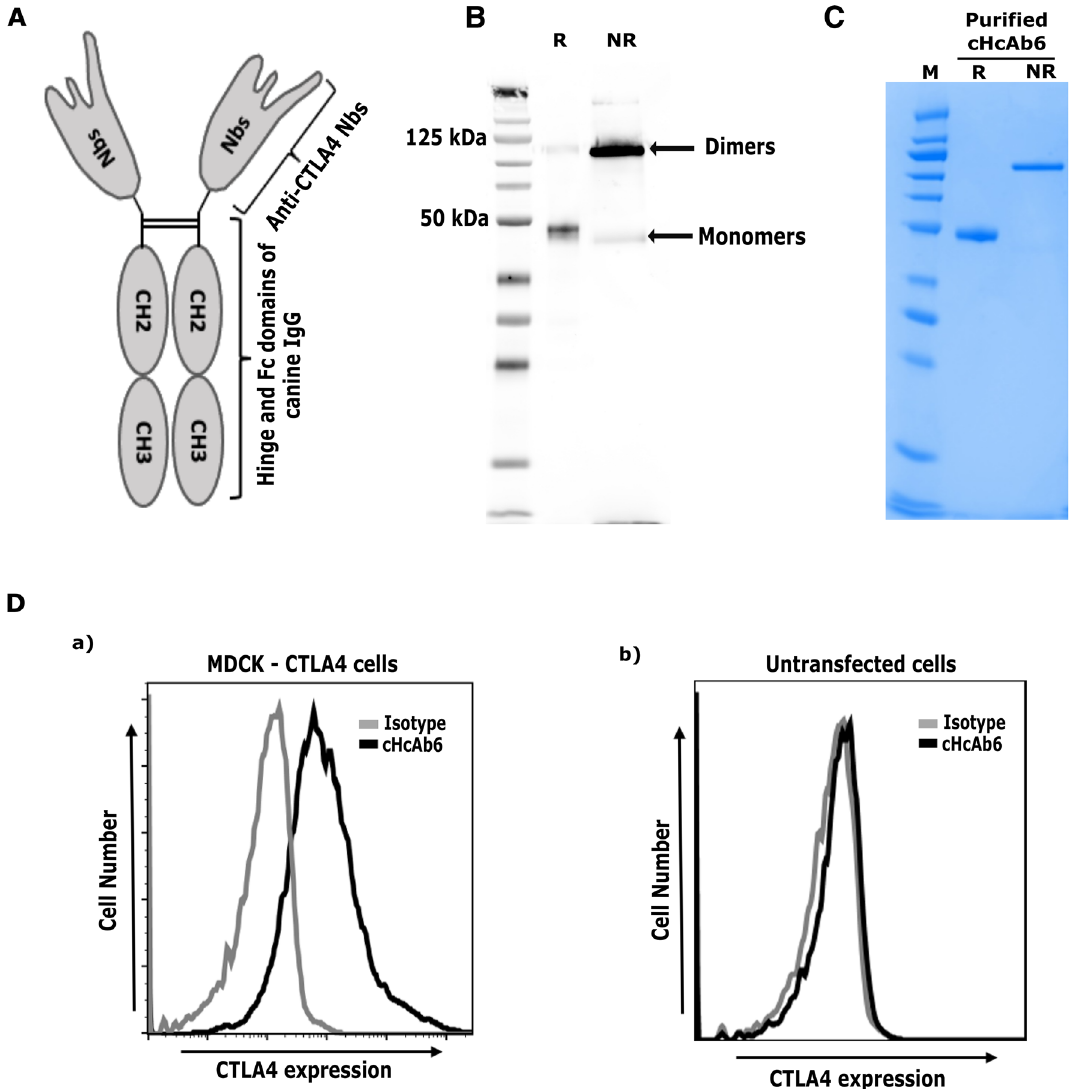
Figure 3. Development of Nb-based anti-CTLA4 heavy chain only antibody (HcAb). ( A ) Predicted structure of cHcAb6. The DNA sequence coding for the cNb6 was genetically fused to the hinge and Fc domains of canine IgG (subclass B). ( B ) The cHcAb6 form dimers as demonstrated by western blotting. The cHcAb6 was expected to form dimers via hinge and Fc domains of canine IgG. The cHcAb6 protein, expressed in ExpiCHO-S cells, was resolved under reducing and non-reducing conditions and detected by anti-IgG Fc antibody. The cHcAb6, as expected, forms dimers of ~ 83 kDa under non-reducing conditions. (R-reducing condition, NR-non reducing). ( C ) Purity of cHcAb6 assessed by SDS-PAGE. The cHcAb6 was expressed and purified from the ExpiCHO-S cells by affinity (Protein A) and size-exclusion chromatography. The purified cHcAb6 was resolved under reducing (R) and non-reducing (NR) condition and stained with GelCode Blue Stain. ( D ) Binding of cHcAb6 to cells expressing canine CTLA4 demonstrated by flow cytometry. MDCK cells transiently expressing CTLA4 were stained with cHcAb6, washed, and bound cHcAb6 was detected using anti-Fc-750 antibody by flow cytometry. cHcAb6 does not bind to untransfected and Foxp3 + ) T cells (Fig. 4B). The expression of CTLA4 on the cell surface was markedly increased after PMA/ Ionomycin stimulation (Fig. 5) as compared to unstimulated T cells.